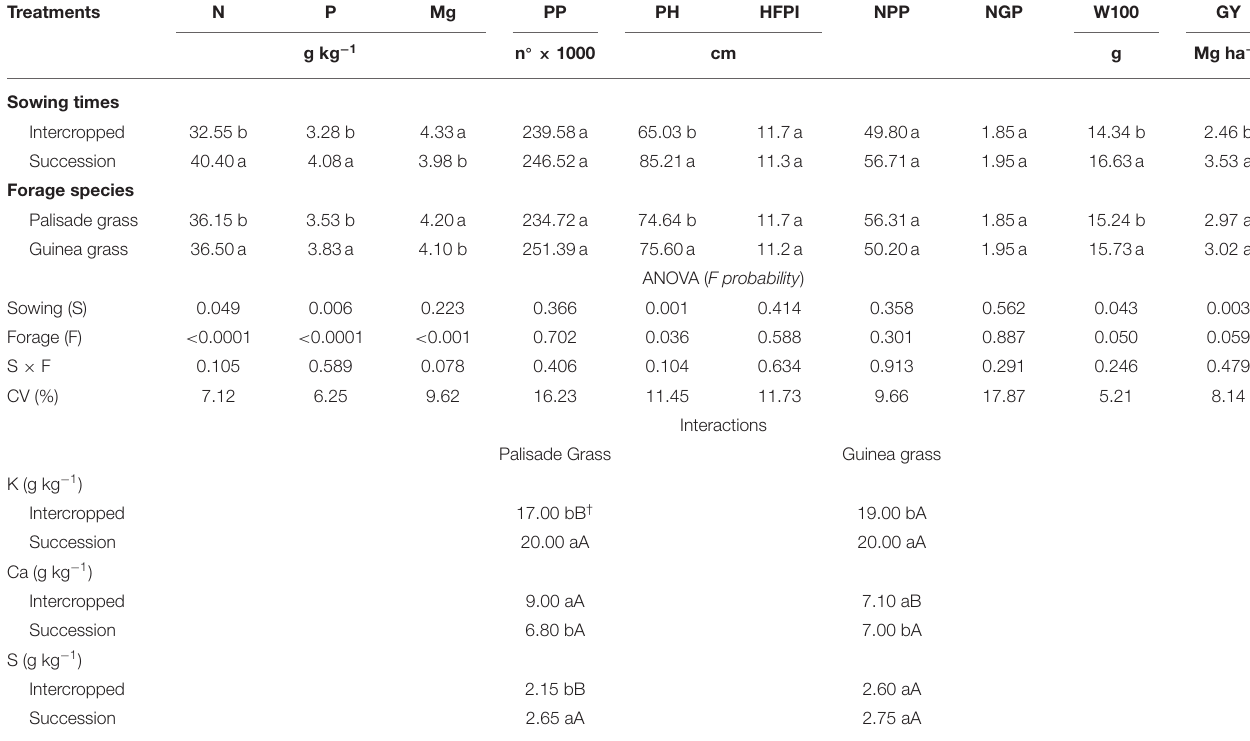
† Valuesfollowedbythesamelowercaseletterinacolumn(separatedbysowingtimesandforagespecies)orthesameuppercaseletterinarowandtheirinteractionsarenotsignificantly different at P < 0.05 according to the LSD test. The results for the 2013 growing season are shown.